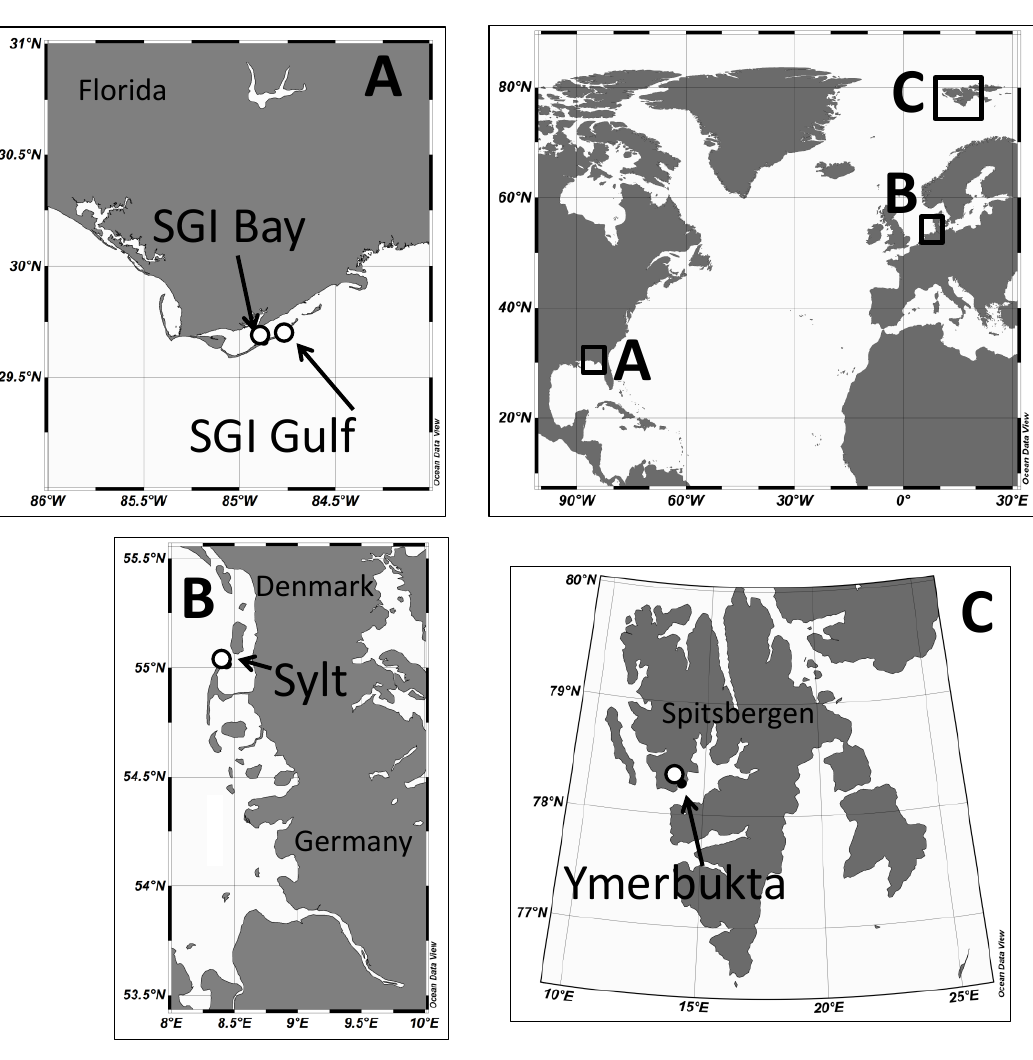
Fig. 1. Location of the sample sites. Table 1. Sample site locations and sediment characteristics. Sites at Ymerbukta and Sylt were intertidal, and the sites at SGI were